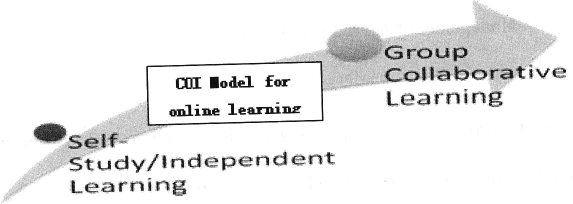
Figure 2. COI model as a means to mobilize learning from self-study/independent learning to group collaborative